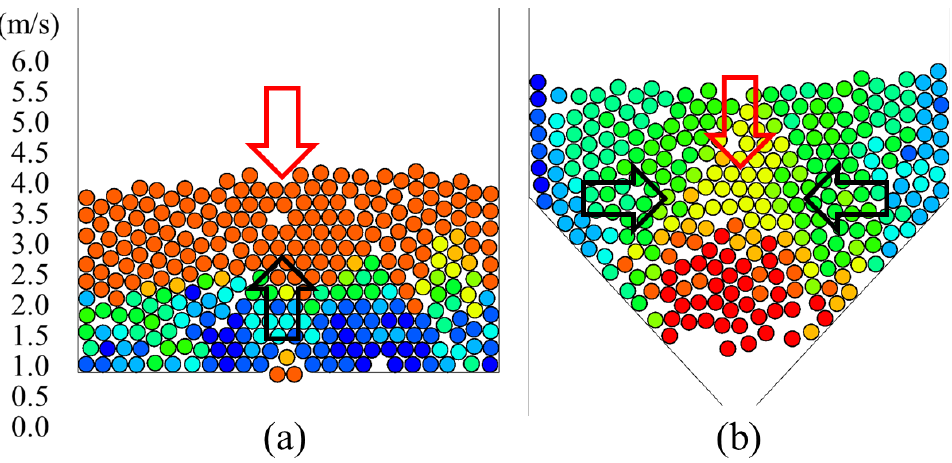
Figure 8. Schematic diagram of particle rebound form in baffle structure with different inclination angles ( a ) θ = 0 ◦ ; ( b ) θ = 45 ◦ . The red arrow represents the part of particles that do not collide with the baffle structure, and the black arrow represents the part of particles that collide and bounce with the baffle structure.